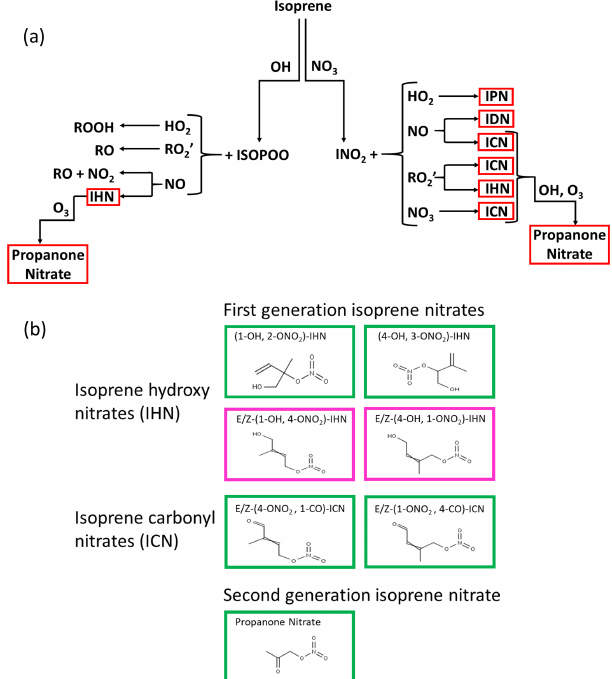
Figure 1. (a) Formation of IN (red boxes) from isoprene oxida- tion by OH and NO 3 : isoprene hydroxy nitrates (IHN), isoprene hydroperoxy nitrates (IPN), isoprene dinitrates (IDN), isoprene car- bonyl nitrates (ICN), and propanone nitrate. (b) The skeletal for- mula of the specific IN discussed in this paper. Box colours are as follows: green represents measured in Beijing, and pink represents measured by the analytical system previously in the laboratory but not discernible in